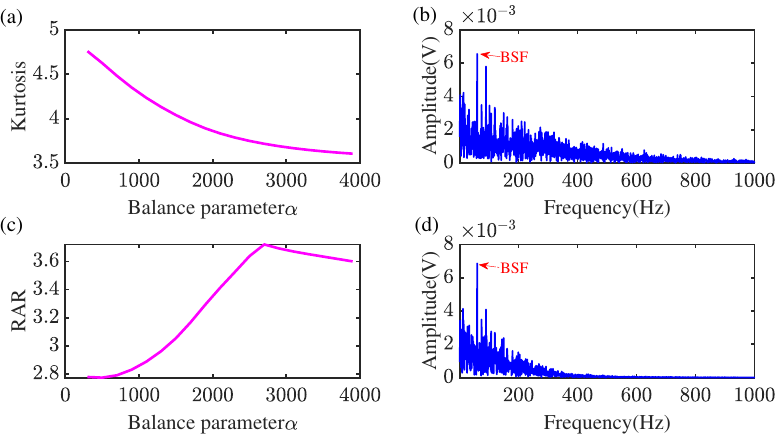
Figure 2. Envelope spectrum results by different evaluation indexes: ( a ) curve of the optimization procedure by kurtosis; ( b ) result optimized by kurtosis; ( c ) curve of the optimization procedure by RAR; ( d ) result optimized by